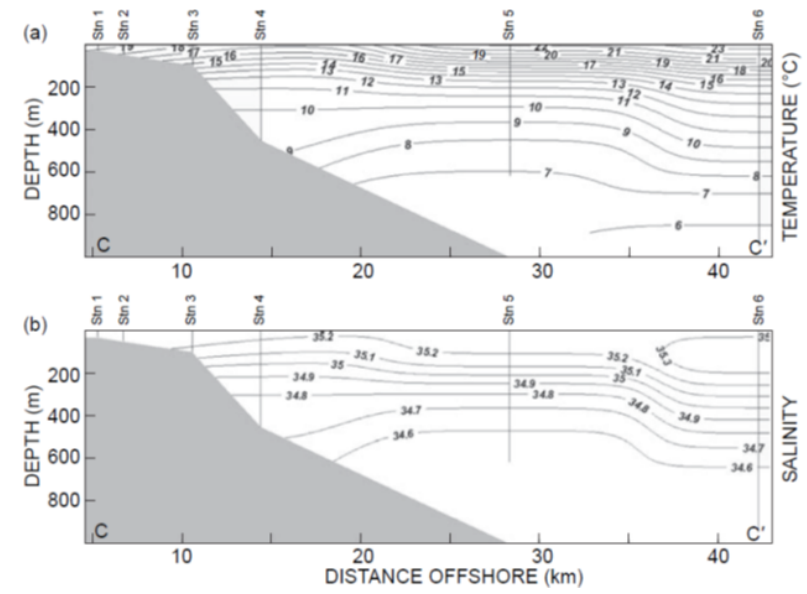
Figure 7. Vertical sections of CTD data collected along a trans-shelf transect off Port St Johns to a depth of 1000m on 4 May 2005 (see Roberts et al., 2010). Both temperature (a) and salinity (b) show slope upwelling with a surface temperature of 16 ◦ C near Station 4 in the centre of the Port St Johns–Waterfall Bluff cyclonic eddy. Graphic after Roberts et al.